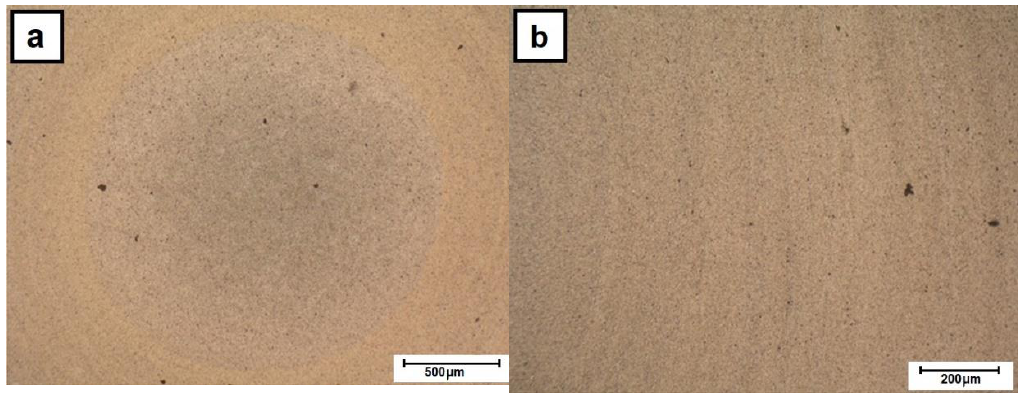
Figure 6. LM images of cross-sections of friction-extruded E alloy at 224 rpm: ( a ) core and ( b ) outer- zone area.